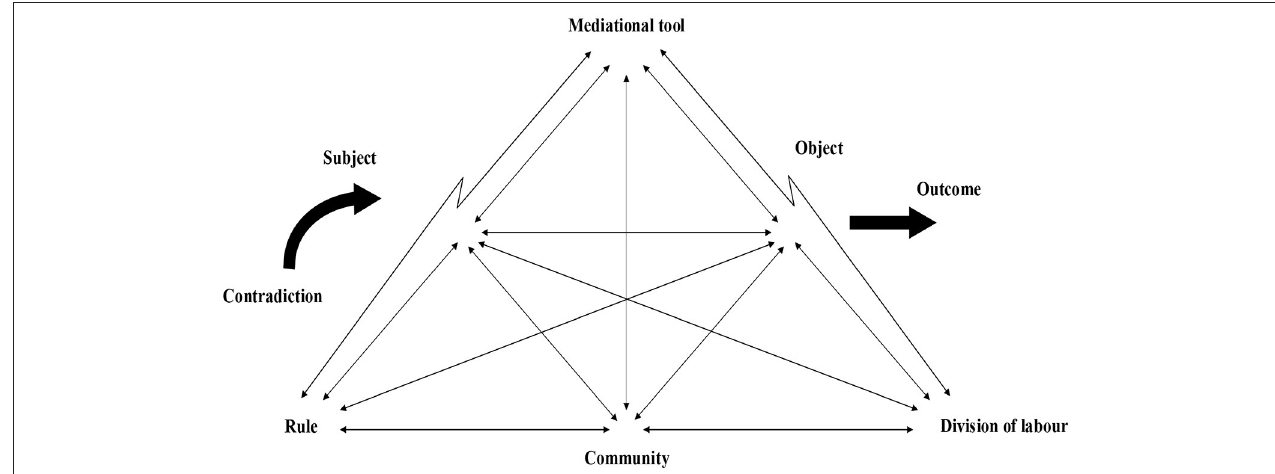
FIGURE 1 | A proposed analytical framework of